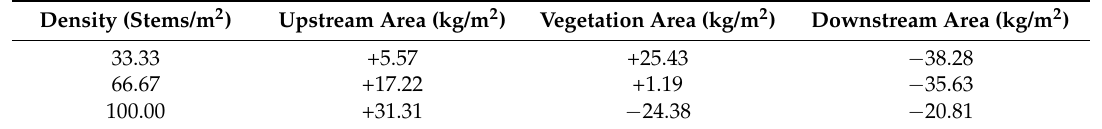
Table 2. Average amounts of sediment budget in different regions.